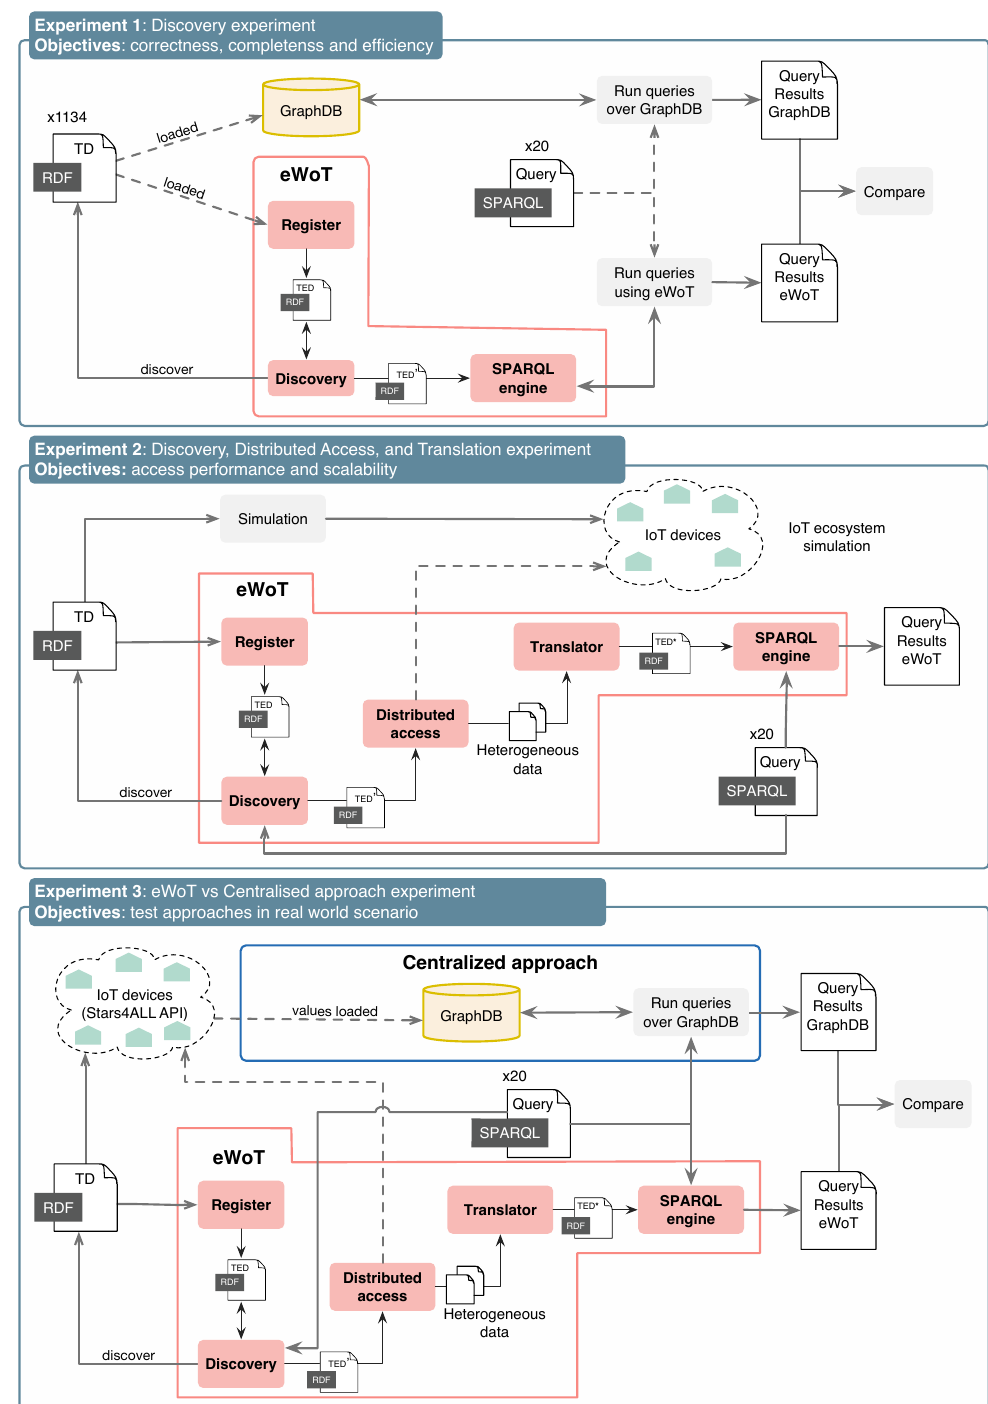
Figure 4. Overview of experimental set ups and